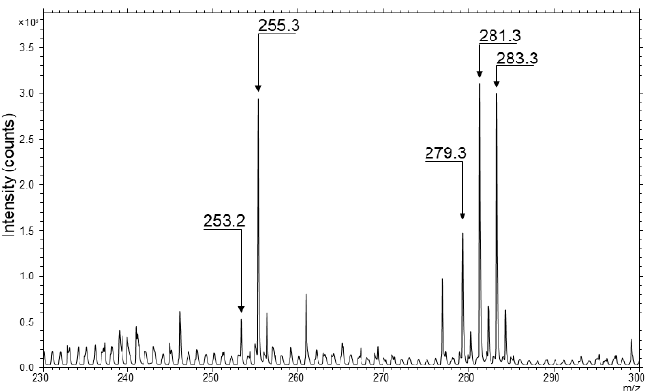
Figure 1. Part of time of flight secondary mass spectrometry (TOF-SIMS) negative ion spectrum of the control skin sample. Marked peaks represent m / z and intensities of carboxylate ions [M − H] − for selected FA in the skin spectrum: palmitoleic acid (C 16 H 29 O 2 − ) at m / z 253.2, palmitic acid (C 16 H 31 O 2 − ) at m / z 255.3, linoleic acid (C 18 H 31 O 2 − ) at m / z 279.3, oleic acid (C 18 H 33 O 2 − ) at m / z 281.3 and stearic acid (C 18 H 35 O 2 − ) at m / z 283.3.